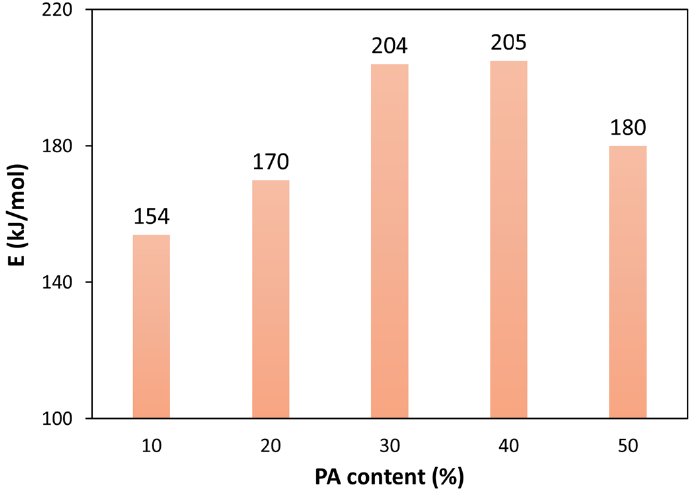
Figure 7. Activation energy values of the thermal decomposition of PLA through a random scission mechanism: the influence of PA mechanism: the influence of PA content.